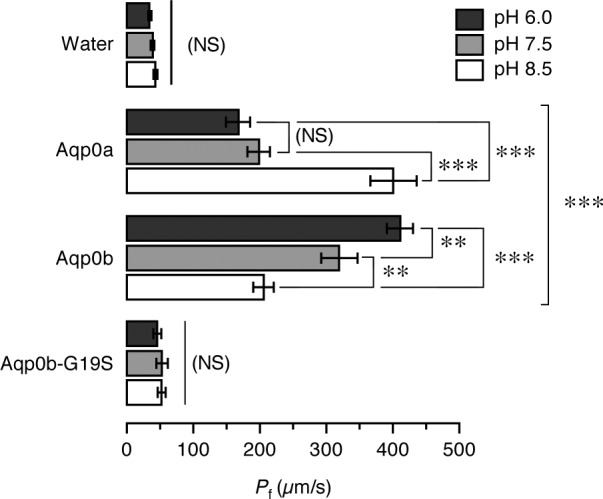
Both zebrafish aqp0a and -0b paralogs encode functional water channels. Osmotic water permeability (Pf) of X. laevis oocytes injected with water or cRNA encoding zebrafish wild-type Aqp0a or -0b or the Aqp0b-G19S mutant. The Pf was calculated using an estimated surface area of 9× the geometric area. Oocytes were exposed to different pH conditions before and during the swelling assays. Data are the mean ± sem (n = 8–12 oocytes per treatment) of 4 independent experiments. Significant differences (*P < 0.05; **P < 0.01; ***P < 0.001) for each construct at the 3 pHs are indicated. The bracket indicates significant differences with respect water-injected oocytes, NS, not significant.